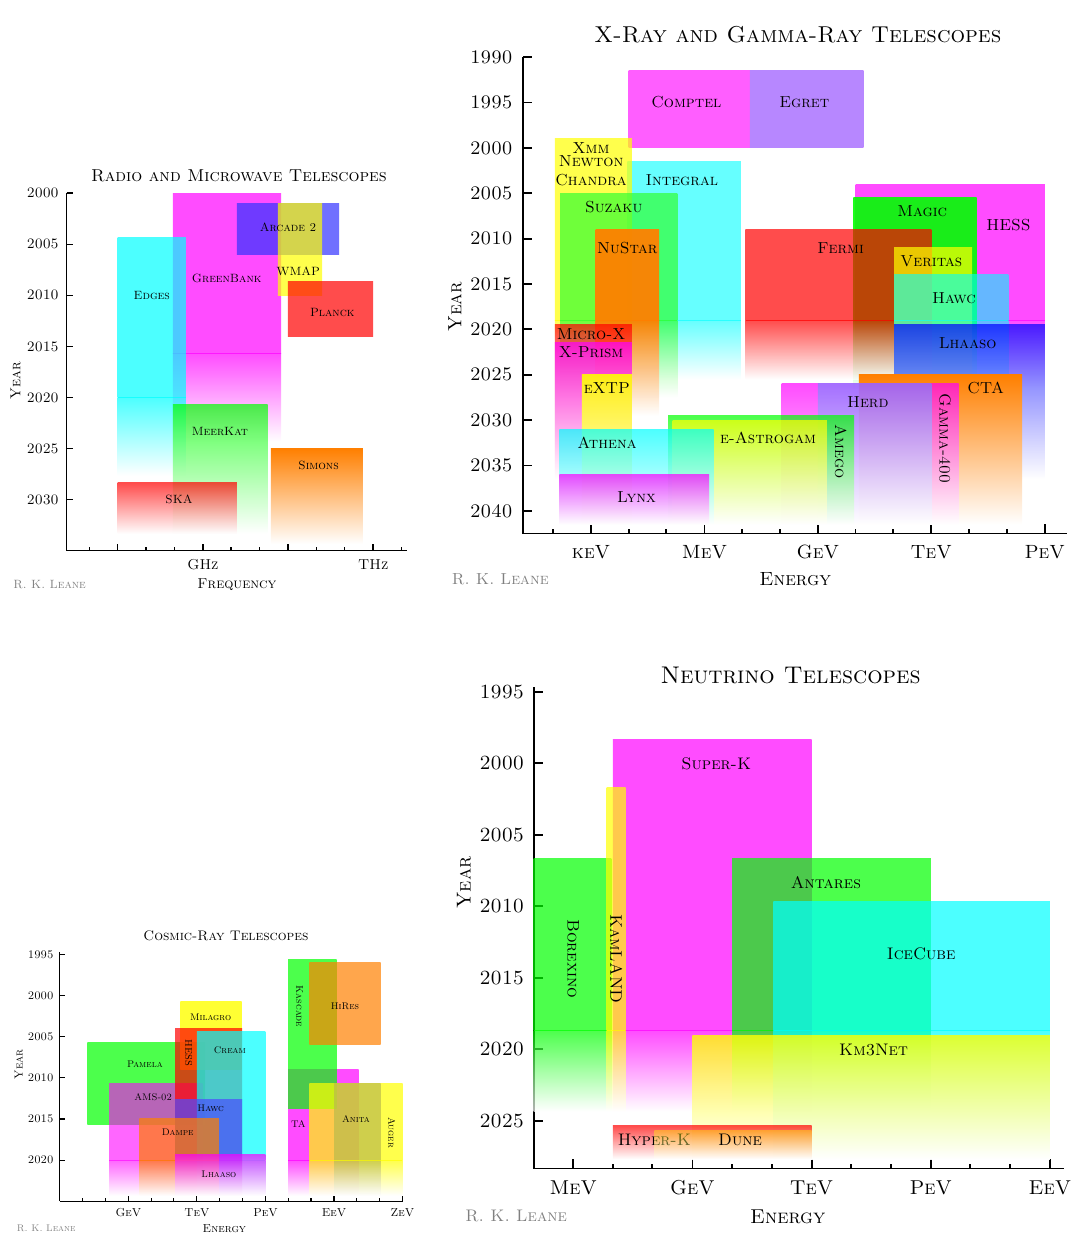
Figure 5: Summary of selected experiments by year operating, and approximate en- ergy sensitivity. All figures are reproduced from Ref. [ 82 ] ; see that work for further